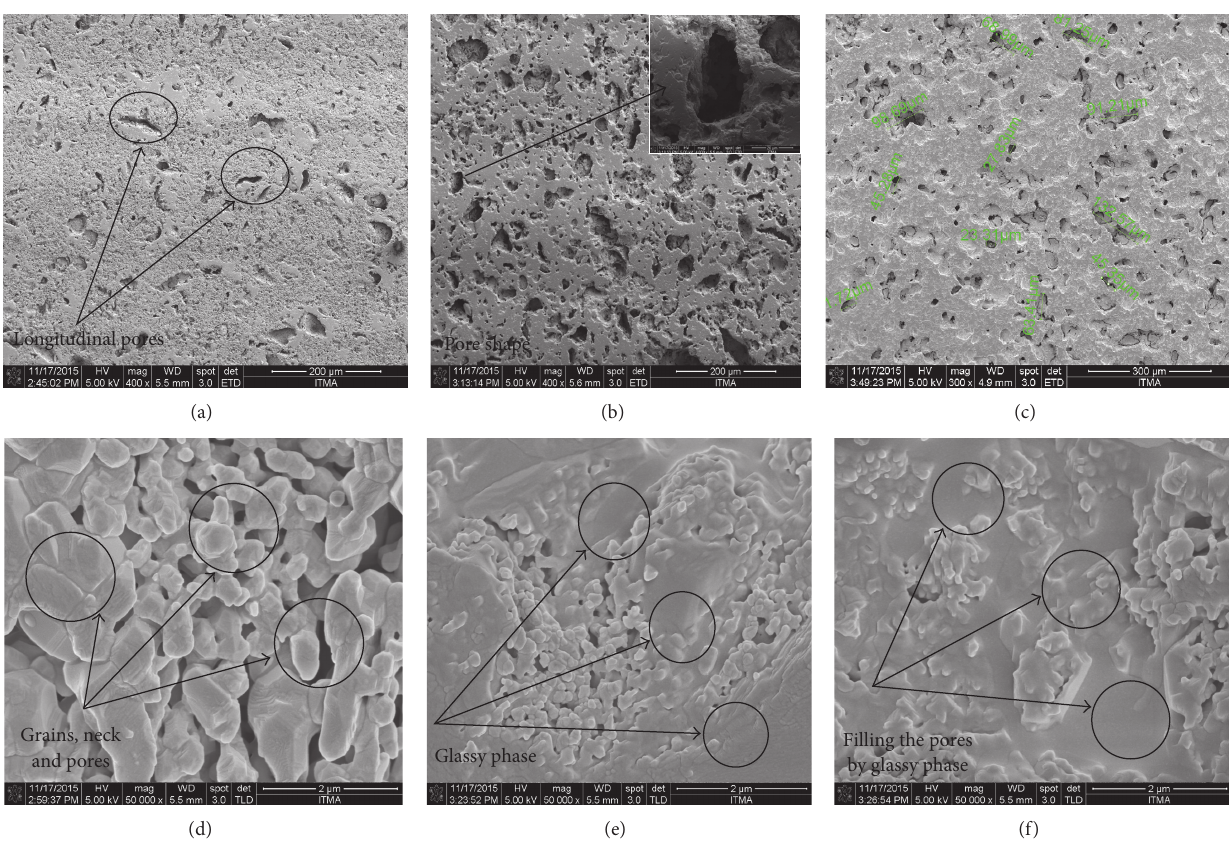
Figure 8: FESEM images of the samples of porous ceramic sintered at 1600 ∘ C for 2 hrs with different ratios of rice husk ash; (a, d) 10wt% rice husk ash, (b, e) 30 wt% rice husk ash, and (c, f) 50wt% rice husk